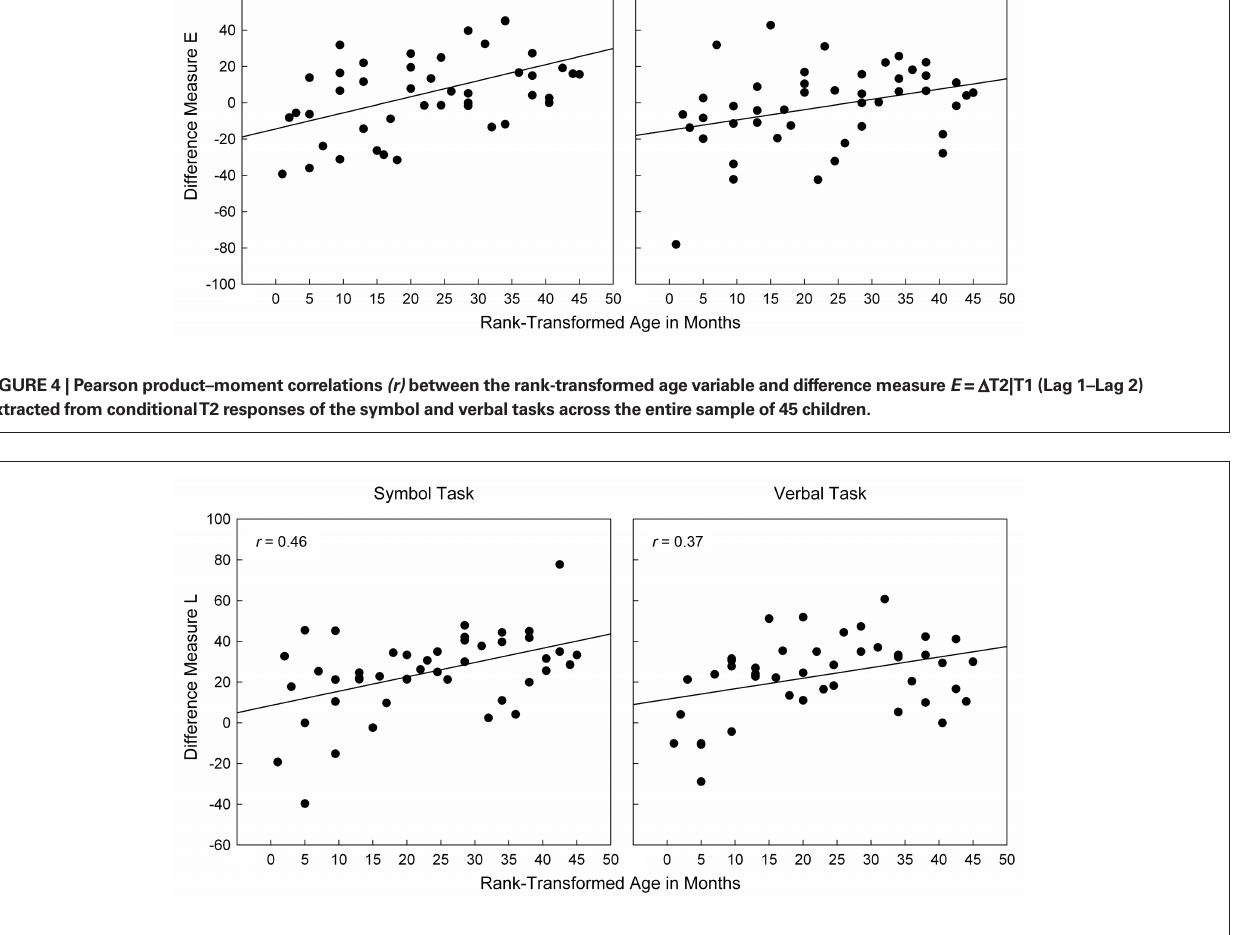
Figure 5 | Pearson product–moment correlations (r) between the rank-transformed age variable and difference measure L = ∆ T2|T1 (lag 8–lag 2) extracted from conditional T2 responses of the symbol and verbal tasks across the entire sample of 45